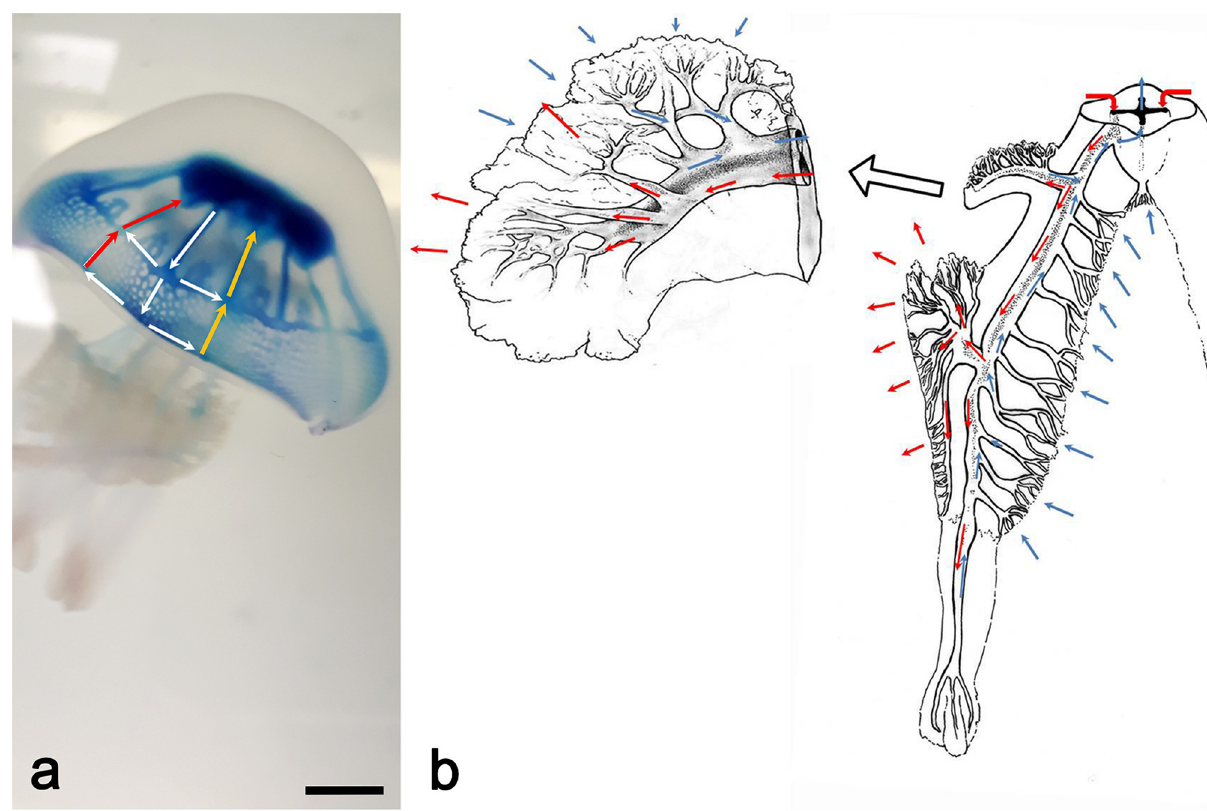
Fig 11. Functional anatomy of the gastrovascular system. (a) Living specimen as in Fig 9c–9e, with superimposed arrows that outline the flow sequence; I, from stomach to the inner ring canal through the adradial canals (white arrows); II, through the inner ring canal towards the per/interradial canals and towards the distal ring canal; III, through the distal ring canal towards the per/interradial canals (yellow arrows) and relative anastomoses; simultaneously a perradial outgoing flux flows from the inner ring canal junction towards the manubrium (red arrows) (scale bar = 1 cm). (b) Drawing showing the bidirectional flux in the manubrium. Blue arrows, incoming flux, red arrows, outgoing flux. Top left, magnification at scapular level.